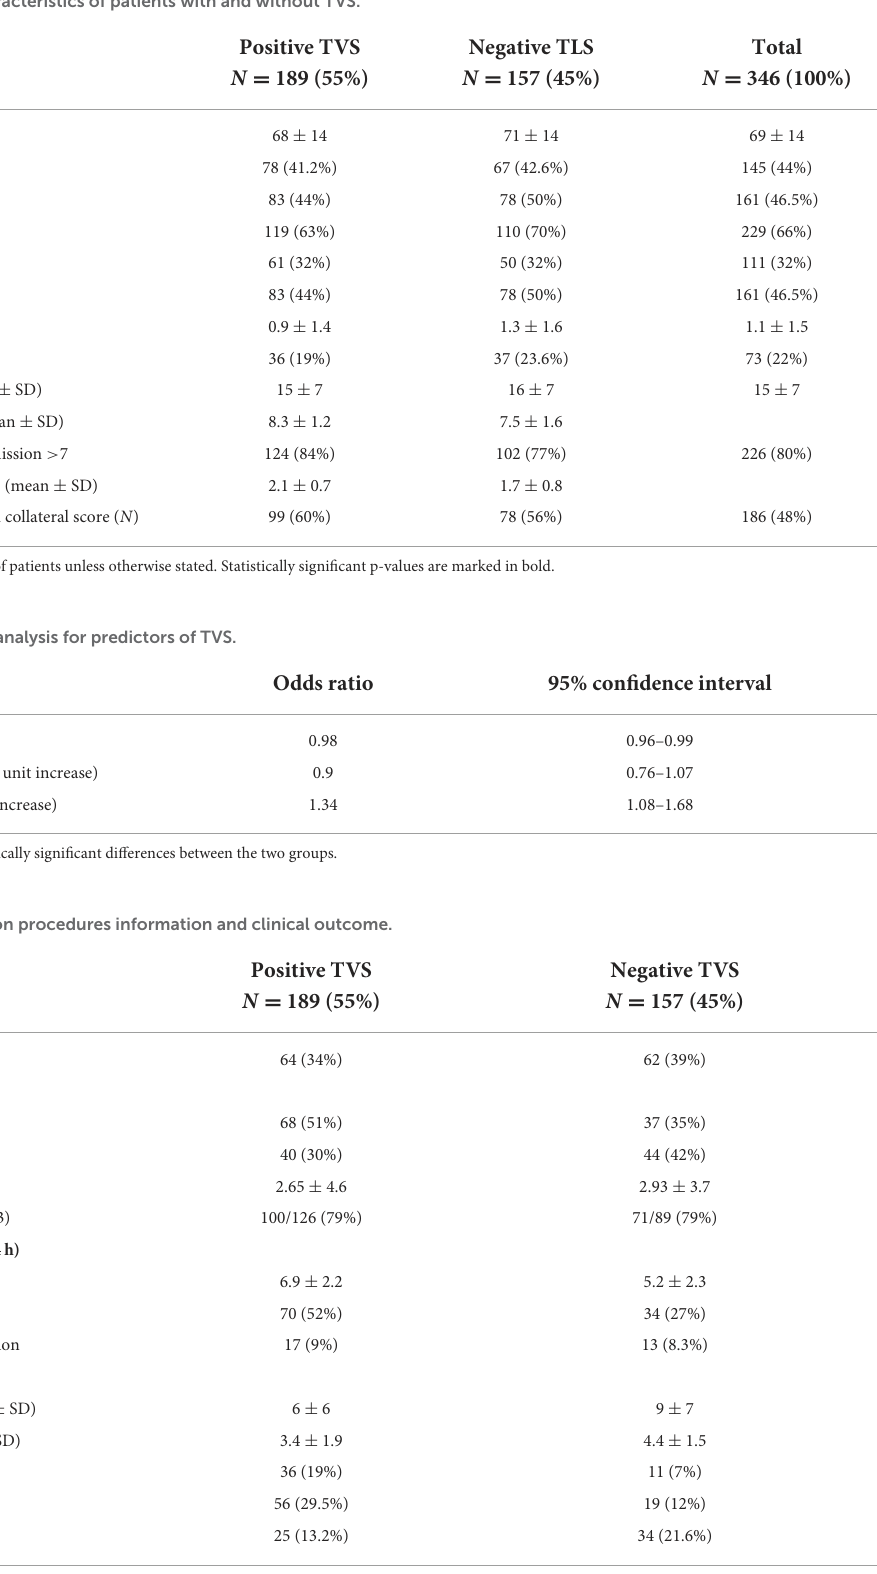
TABLE 1 Baseline characteristics of patients with and without TVS.